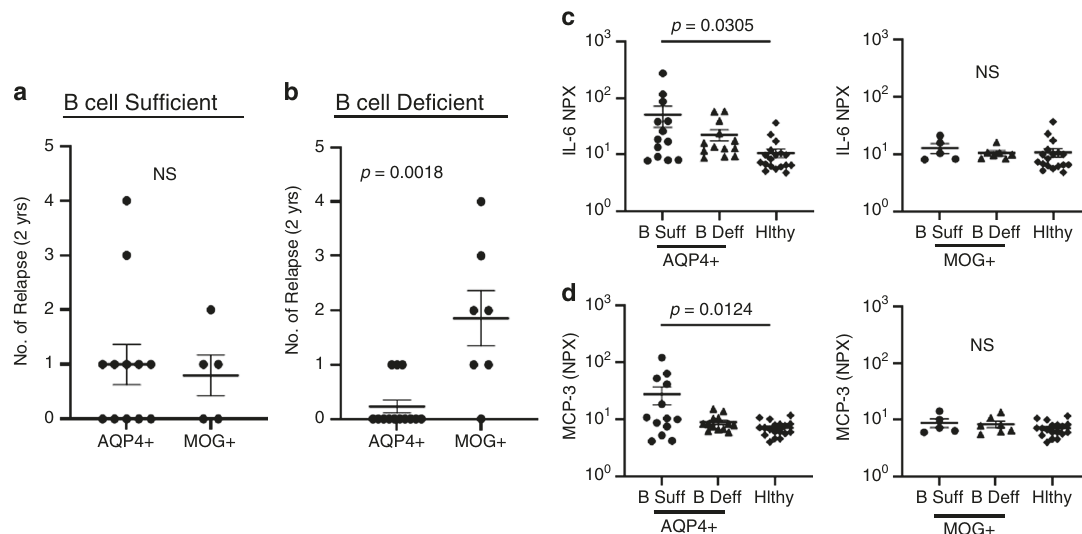
Fig. 4 Effects of B-cell depletion on AQP4-Ig + and MOG-Ig + NMOSD. a Comparison of relapse rates in AQP4-Ig + ( n = 12) and MOG-Ig + NMOSD ( n = 5) who are B-cell-suf fi cient. b Comparison of relapse rates in AQP4-IgG + ( n = 13) and MOG-IgG + ( n = 7) NMOSD who are B-cell-de fi cient. P values were determined using two-tailed Mann – Whitney tests. Serum c IL-6 and d MCP-3 levels in B cell-suf fi cient AQP4-IgG + patients ( n = 13), B-cell-de fi cient AQP4-IgG + patients ( n = 13), B-cell-suf fi cient MOG-IgG + patients ( n = 5) and B-cell-de fi cient MOG-IgG + patients ( n = 7) were compared with healthy controls ( n = 18). P values were determined using one-way ANOVA tests with multiple comparisons corrected by the Tukey ’ s method. Error bars indicate the S.E.M. Source data are provided as a Source Data fi